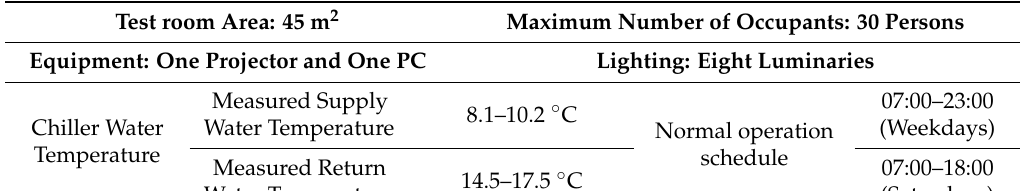
Table 3. Information summary of the university design studio.